Question: Does the figure show an increasing or a decreasing trend?
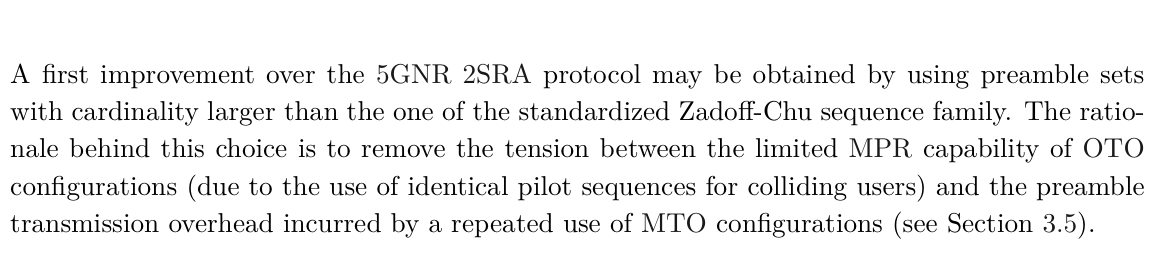
Answer: increasing